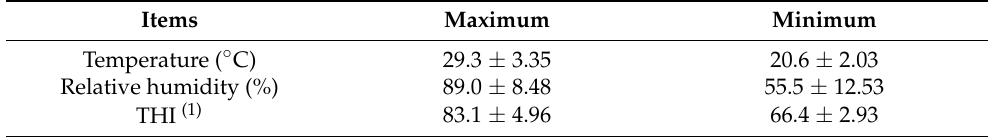
Table 8. Maximum and minimum temperature, relative humidity and temperature–humidity index during the experiment on Hanwoo steers.